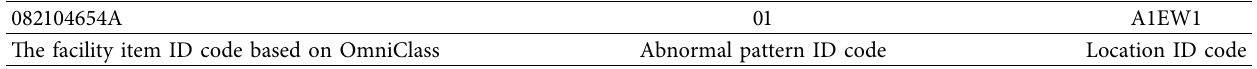
Table 2: Illustration of individual facility ID